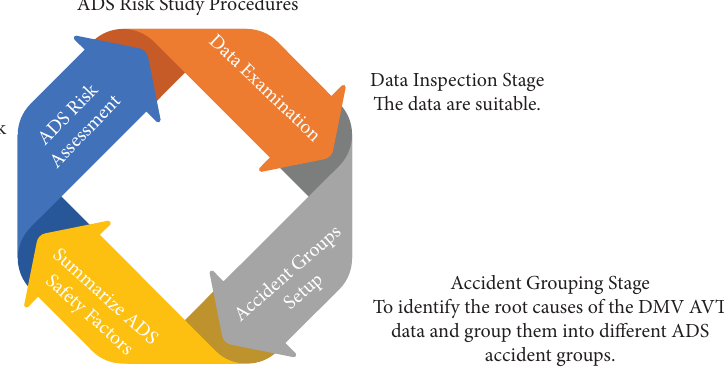
Figure 1: ADS risk study approach